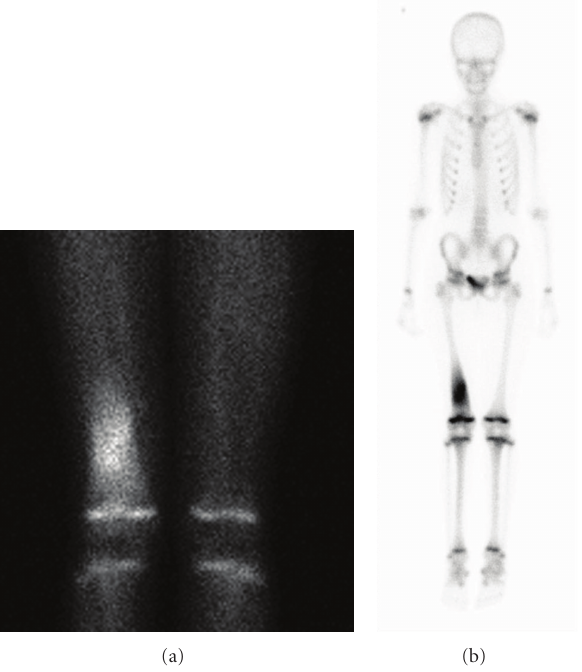
Figure 3: Frontal projection femoral blood pool (a) and 2-hour delayed whole-body (b) images from 99 mTc MDP bone scan. Intense activity is present at the right distal femoral lesion. There were no other active sites, confirming this to be a solitary